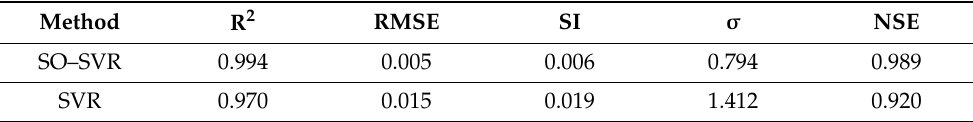
Table 11. Evaluation of SO–SVR method in the test stage.